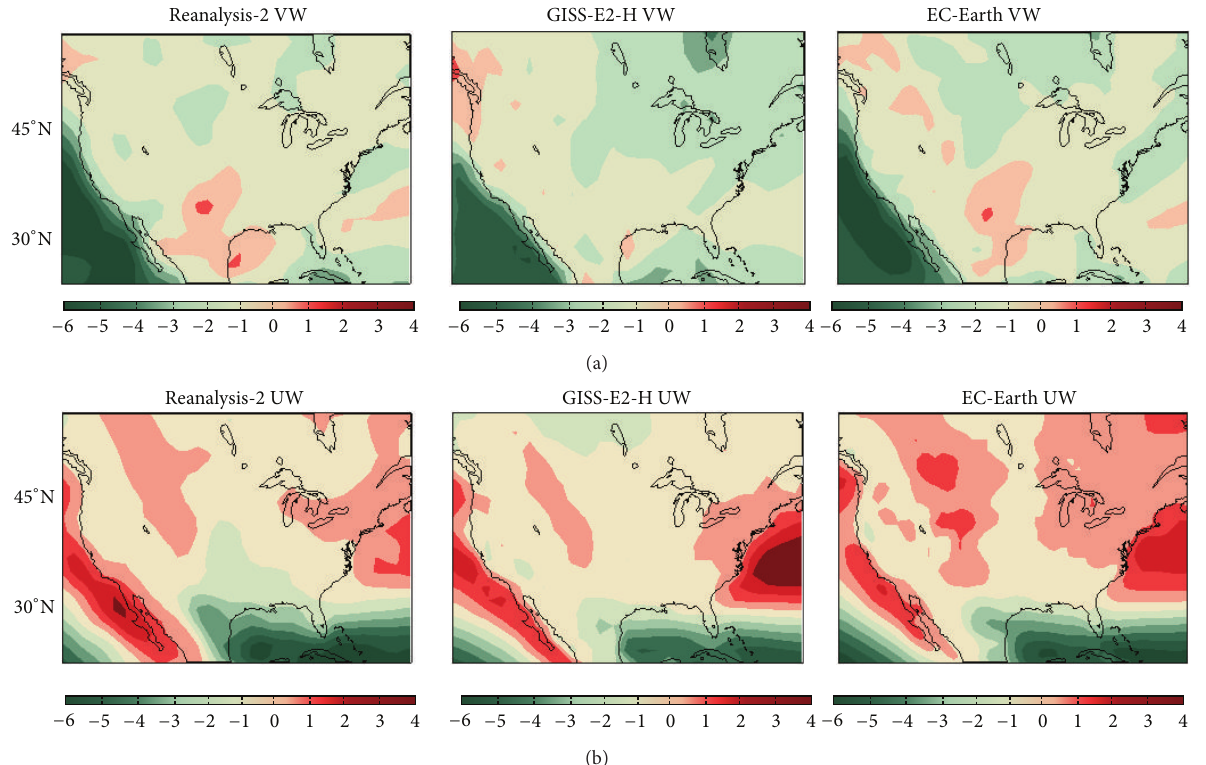
Figure 5: A comparison of the 1979–1999 climatology of the V -component (a) and 𝑢 -component (b) of the 10 m wind over North America from reanalysis-2 (left), GISS-E2 H historical run (middle) and EC-Earth historical run (right). The color scale, in m/s, is shown at bottom. Red and green indicate positive and negative